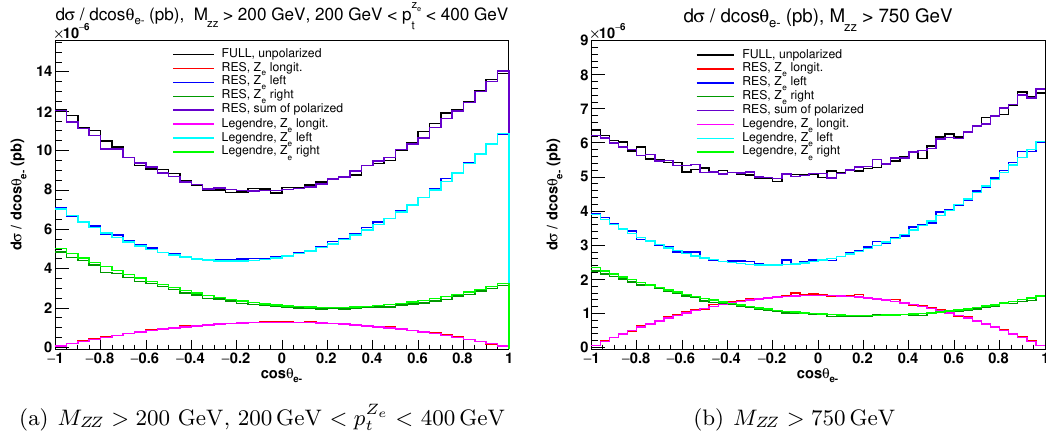
Figure 3 . ZZ scattering: cos (cid:18) distributions in two di(cid:11)erent kinematic regions, in the absence e (cid:0) of leptonic cuts, for a polarized Z decaying into e + e (cid:0) . The pink, azure and light green curves represent respectively the longitudinal, left and right contributions obtained by expanding the full angular distribution (black curve) on the (cid:12)rst three Legendre polynomials. The red, blue and dark green histograms represent respectively the longitudinal, left and right contributions computed with polarized amplitudes. The Z decaying to (cid:22) + (cid:22) (cid:0) is unpolarized. In (cid:12)gure 3 we show the cos (cid:18) distributions in two kinematic regions which are e (cid:0)